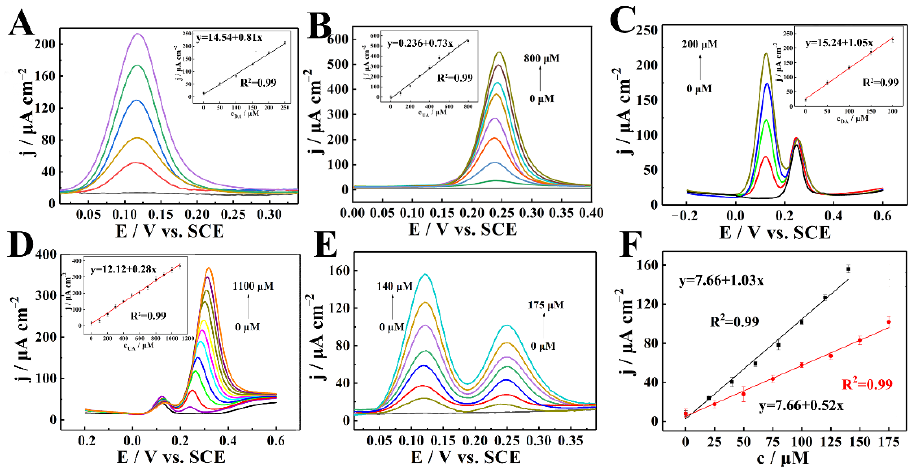
Figure 5. ( A , B ) DPV of CuNPs/CN/GCE in 0.2 M N 2 -statured PBS (pH = 7) with different DA ( A ) and UA ( B ). ( C ) DPV of CuNPs/CN/GCE in 0.2 M N 2 -statured PBS (pH = 7) containing 200 μ M UA to detect DA. ( D ) DPV of CuNPs/CN/GCE in 0.2 M N 2 -statured PBS (pH = 7) containing 50 μ M DA to detect UA. ( E ) DPV of CuNPs/CN/GCE in 0.2 M N 2 -statured PBS (pH = 7) to detect DA and UA. ( F ) Curve of peak current density and concentration. Insets: plots of peak current density versus concentration.